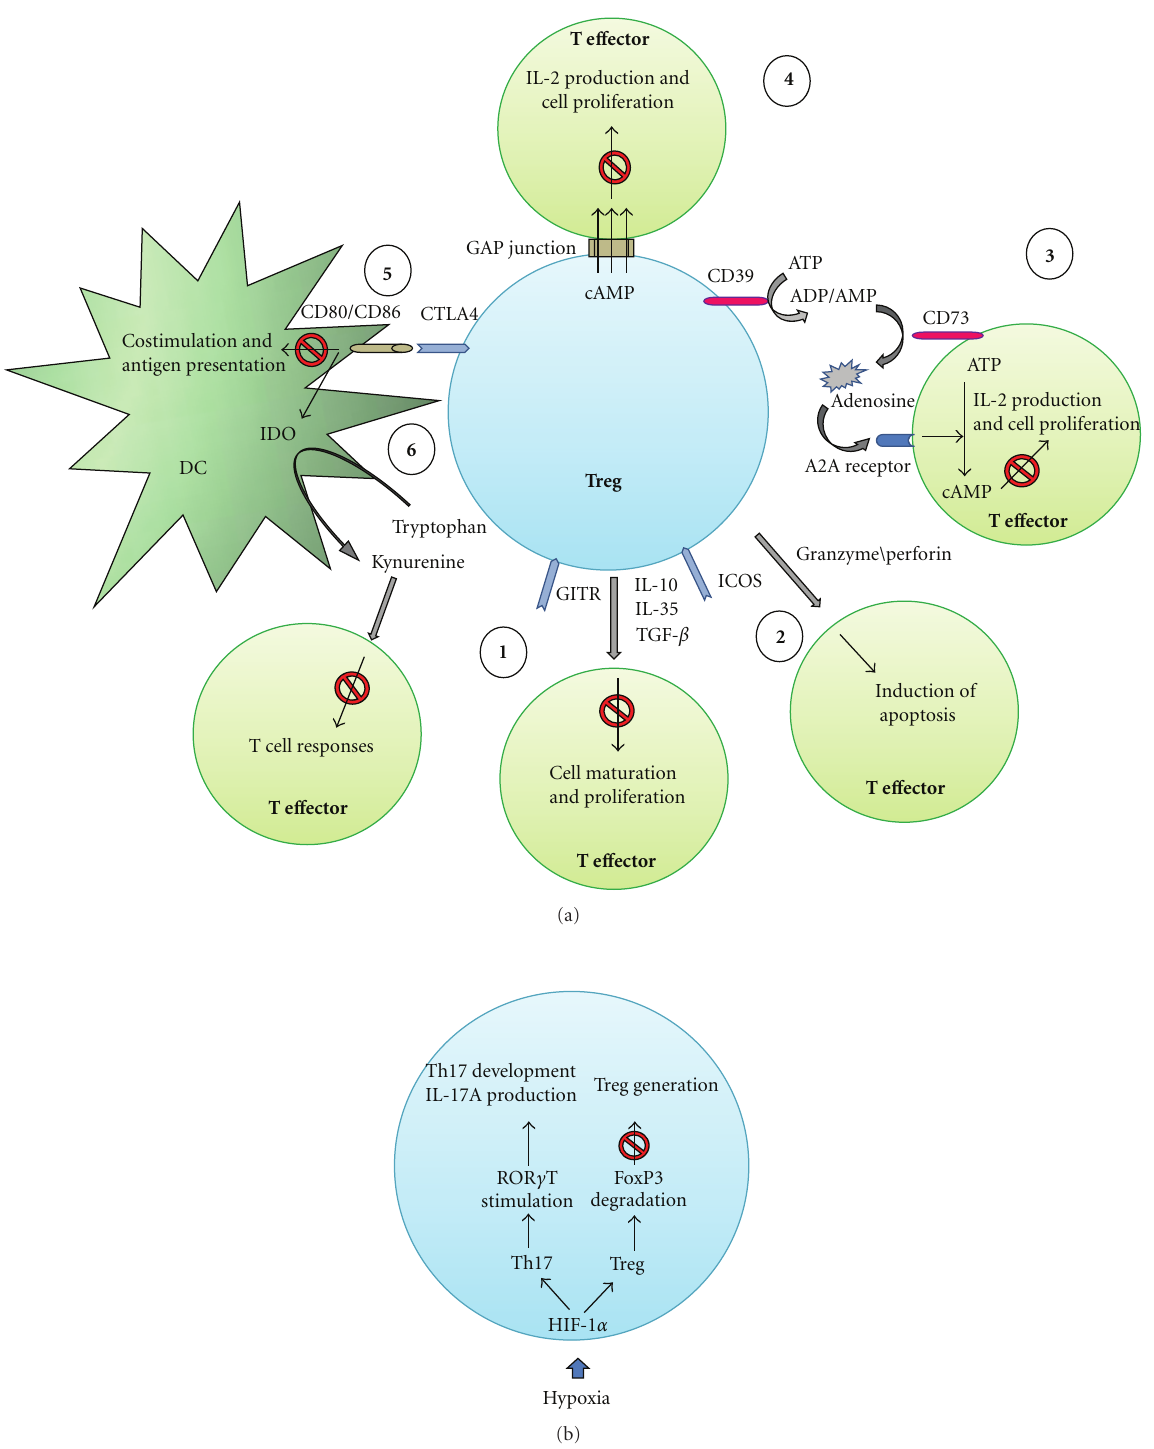
Figure 1: The Treg regulatory pathways. (a) The ability of Tregs to induce immune suppression is mediated via (1) inhibitory cytokines; (2) induction of apoptosis by granzyme/perforin pathway; (3) CD39/CD73/adenosine pathway; (4) direct transfer of cAMP via GAP junction; (5) inhibition of DC function by CD80/CD86 and CTLA-4 interaction; and (6) the catabolism of tryptophan via IDO enzyme. (b) Dual function of HIF-1 α in regulation of Treg and Th17